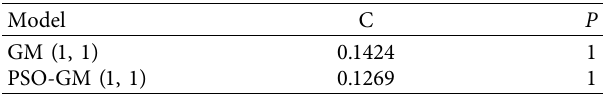
Table 4: Accuracy assessment table.